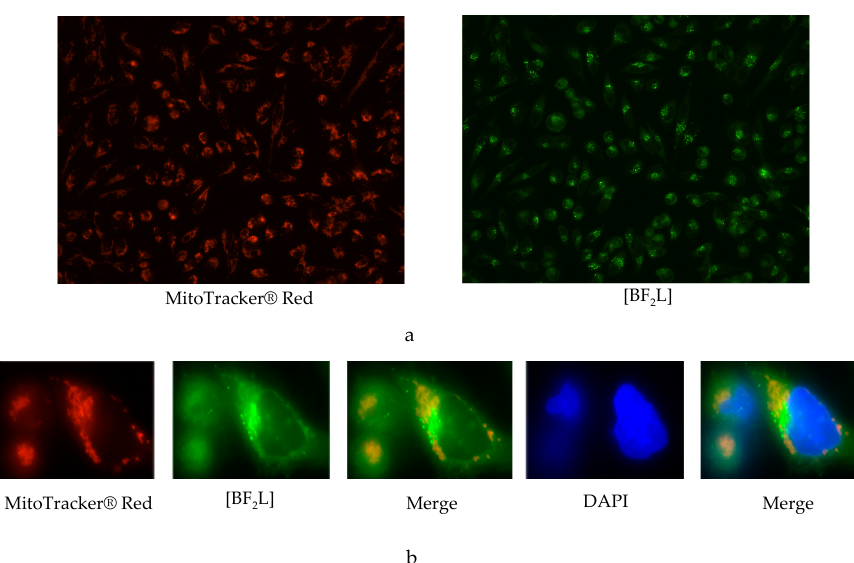
Figure 6. Subcellular distribution of [BF 2 L] (green) co-stained with MitoTracker® Red CMXRos (red) in GIST T-1R cancer cells. Cells were stained with DAPI (blue) to outline the nucleus. The experiments were performed in the triplicates. The images were shown at 20x ( a ) and 100x ( b ) magnifications.